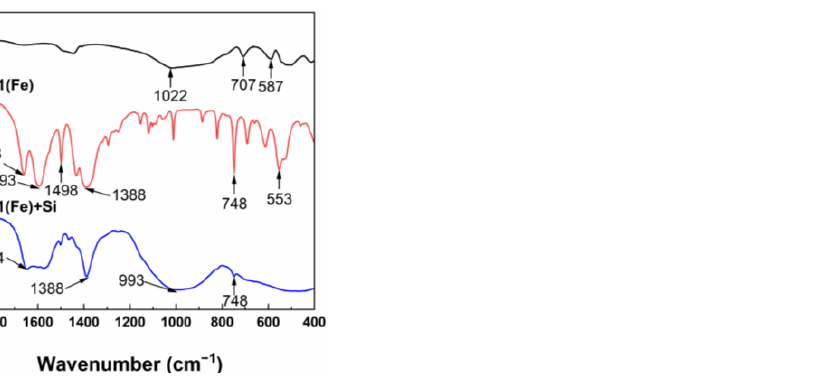
Figure 2. ATR-FTIR spectra of Si (black), MIL-101(Fe) before adsorption (red) and MIL-101(Fe) after adsorbing silicic acid (blue).